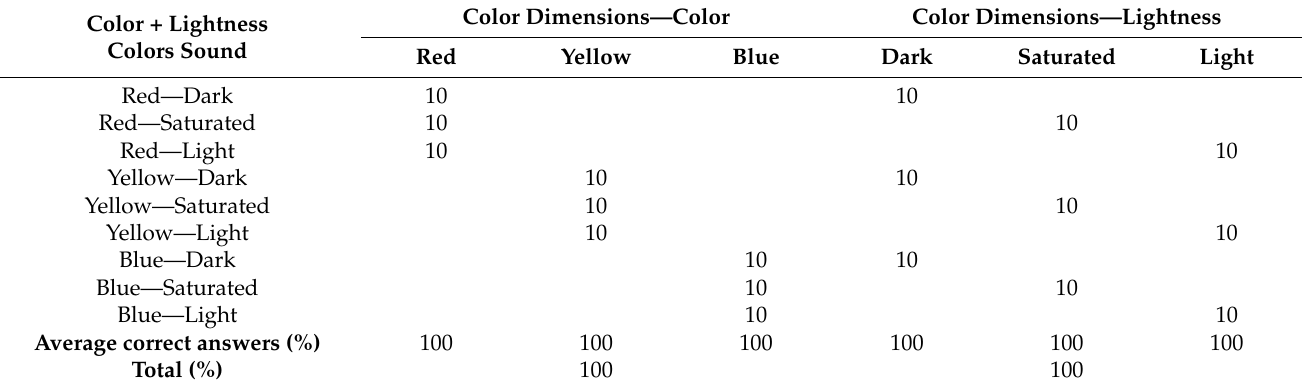
Table 9. total color codes identification test in experiment 2 (color +